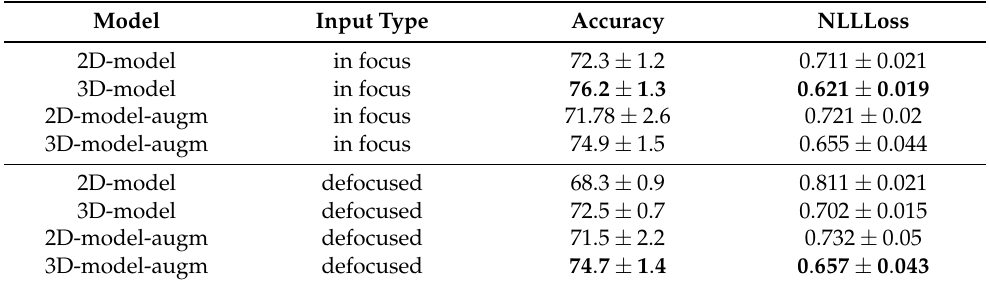
Table 1. Performance of the different models. The models marked with augm are trained with hologram defocus augmentation. Top scores are highlighted in bold.